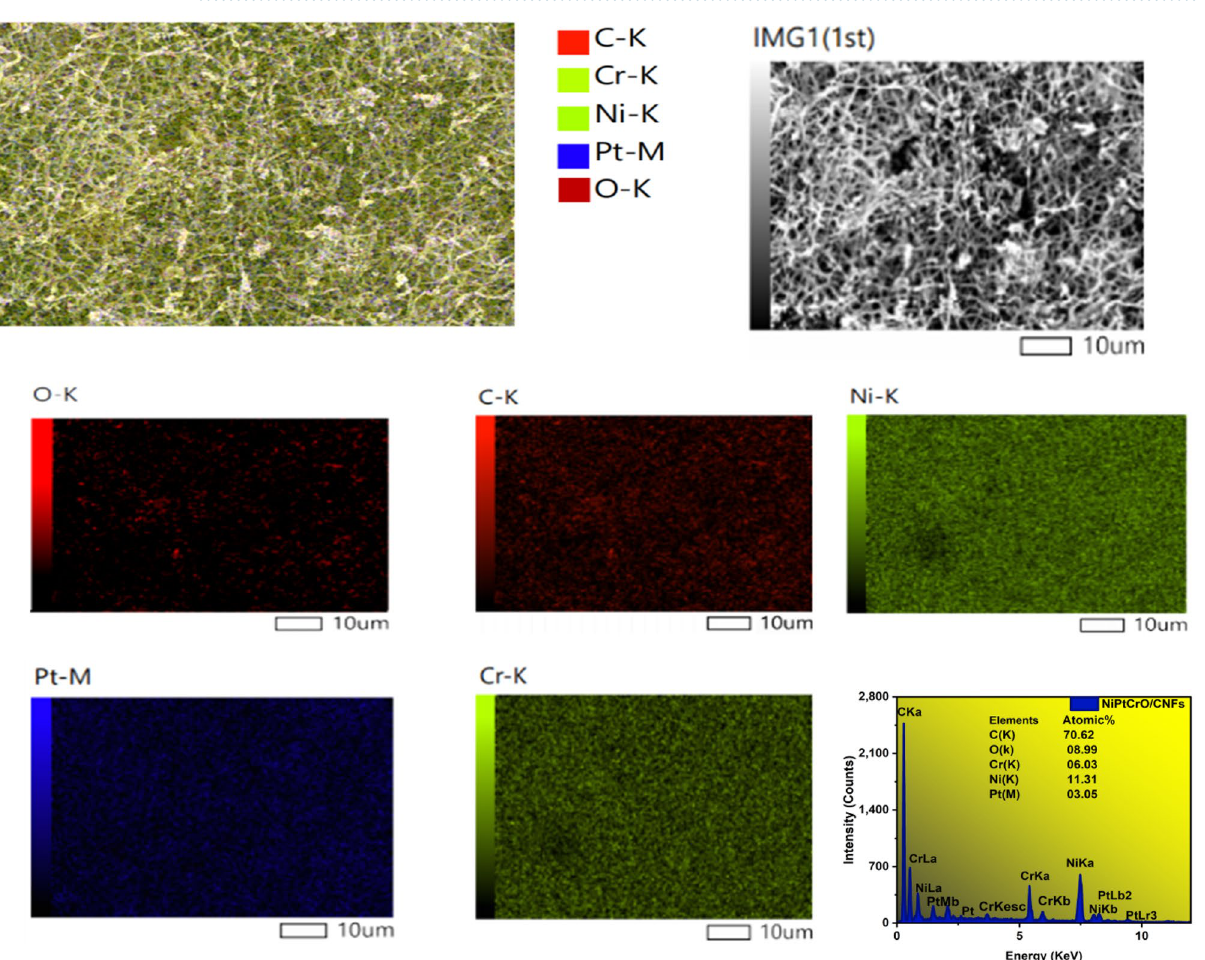
Figure 3. SEM matched with elemental mappings and EDX analyses for the sample Ni 11 Pt 3 Cr 6